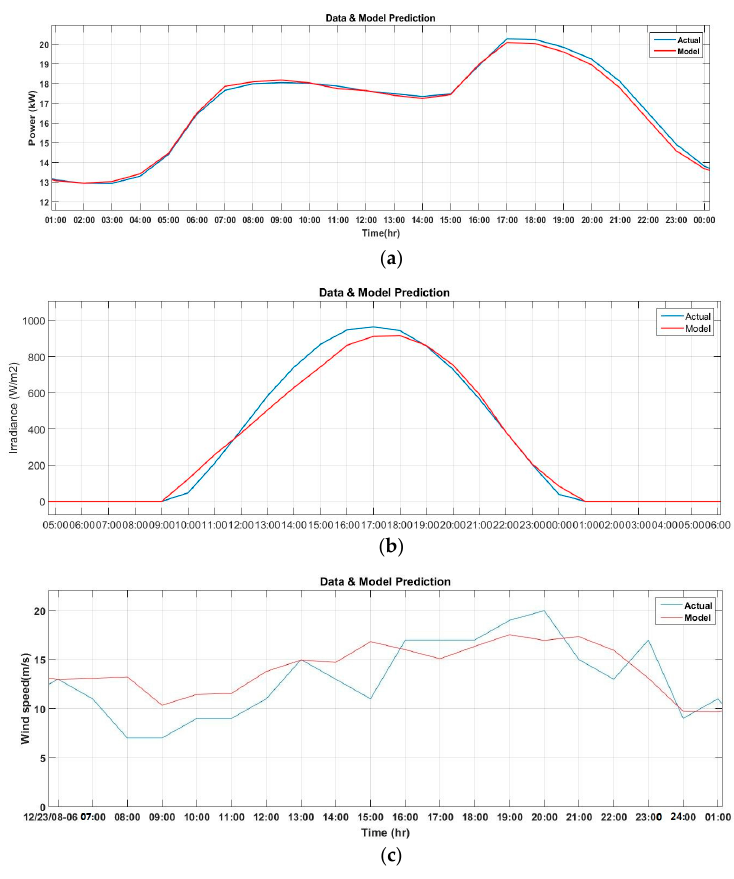
Figure 3. The output of the forecasting system. ( a ) Load demand. ( b ) Irradiance. ( c ) Wind speed.